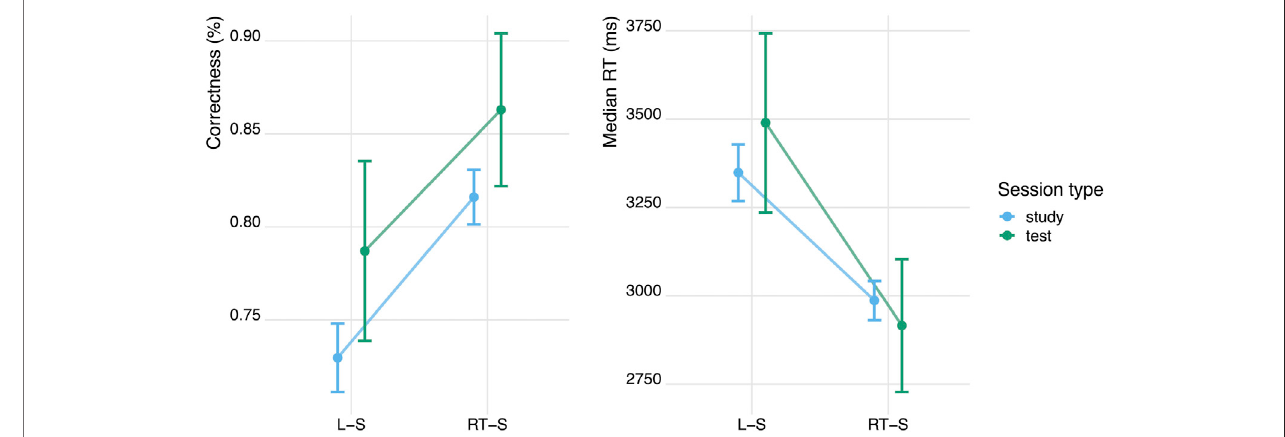
FIGURE 5 | Accuracy and median reaction times for RT-adaptive (RT-S) and Leitner-adaptive (L – S) speech-based learning. Error bars are standard errors.